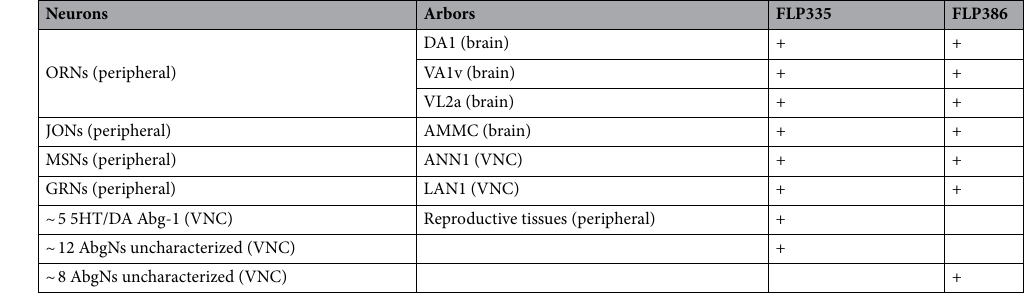
Table 1. Summary of fru expression restricted by FLP 335 or FLP 386 in combination with fru -GAL4 and tsh- GAL80. In brackets is the anatomical location of the neurons or arbors. ORN olfactory receptor neuron, JON Johnston’s organ neuron, MSN mechanosensory neuron, GRN gustatory receptor neuron, AbgN abdominal neuron, 5HT serotonergic neuron, DA dopaminergic neuron, VNC ventral nerve